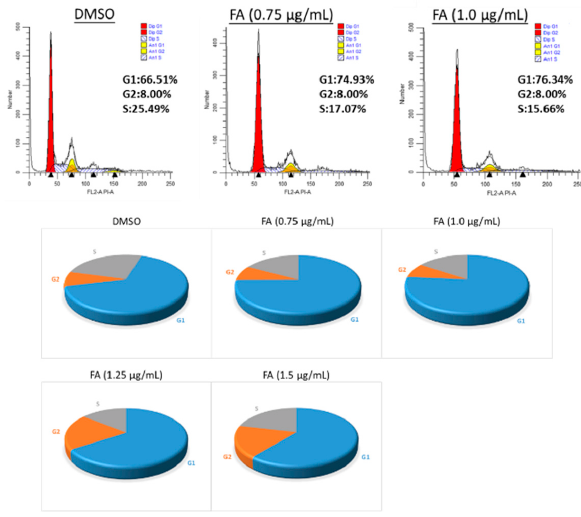
Figure 3. Flow cytometric assessment of apoptosis. HCT-116 cells were treated with DMSO (0.5%), FA (0.65, 1.32 or 2.64 μ g/mL), or paclitaxel (PTX) (10 ng/mL) for 48 h prior to labeling with propidium iodide (PI) and fluorescein isothiocyanate (FITC)-annexin V. The Q1-UL (red) quadrant shows the percentage of necrotic cells, the Q2-UR (green) and Q4-LR (magenta) quadrants represent late and early apoptotic events, respectively, while the Q3-LL (blue) quadrant denotes the population of viable cells. ( a ) Shown here are the representative analytic plots of four independent experiments. ( b ) Apoptotic data (i.e., Q2-UR + Q4-LR) in the bar chart are expressed as mean ± standard deviation (SD) of four independent experiments (* p < 0.001 when compared to DMSO control).